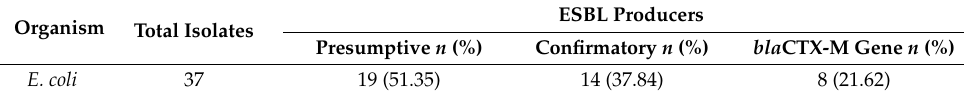
Table 5. Prevalence of ESBL positive E. coli and bla CTX-M gene.